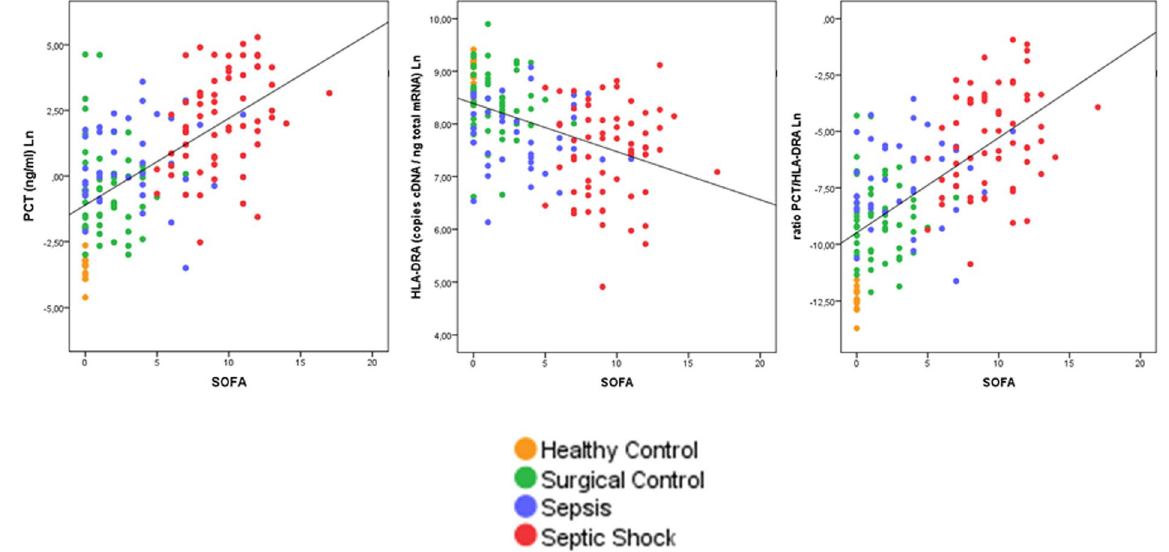
Figure 1. Dot plot showing patients‘ distribution depending on SOFA score and biomarkers‘ levels in the derivation cohort. Spearman correlation coefficients were 0.625, − 0.488, 0.649 respectively ( p < 0.001).